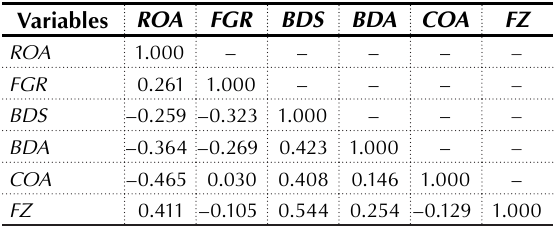
Table 2. Correlation